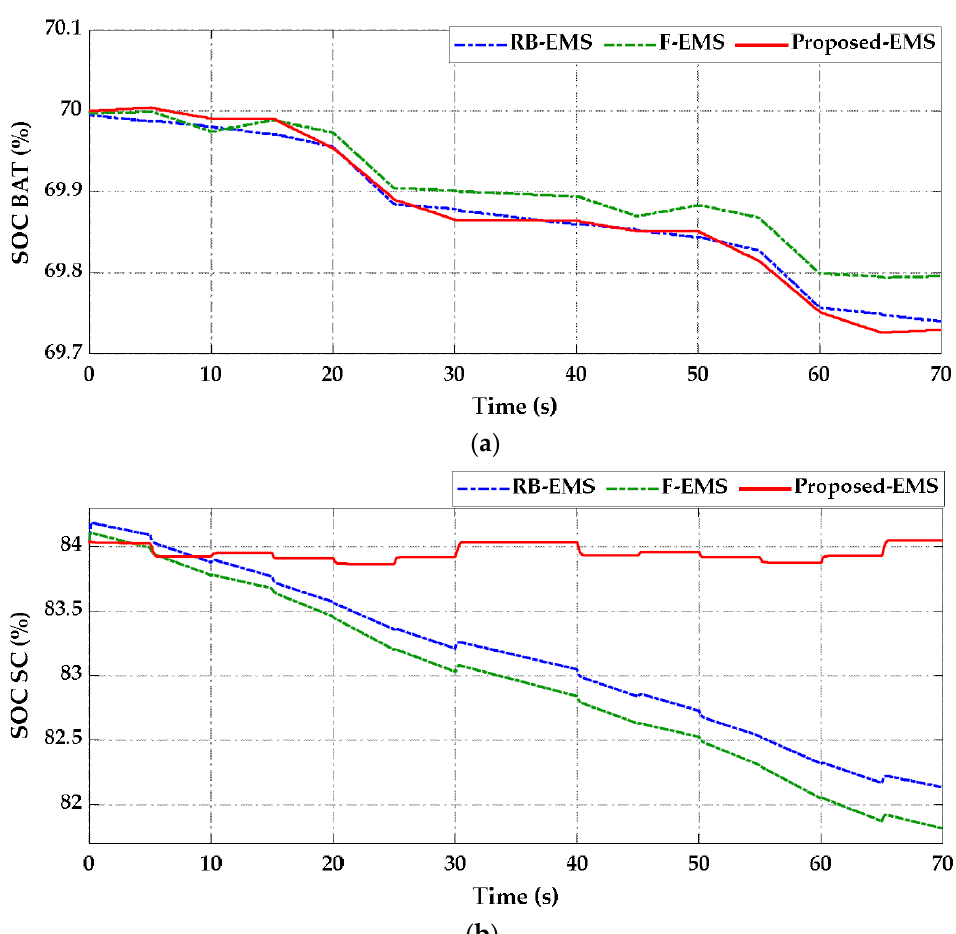
Figure 21. The SOC comparison. ( a ) BAT. ( b ) SC.